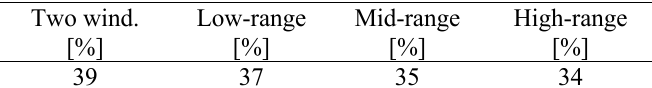
Table 7: The maximum errors of Mohan’s “modified Wheeler formula”.